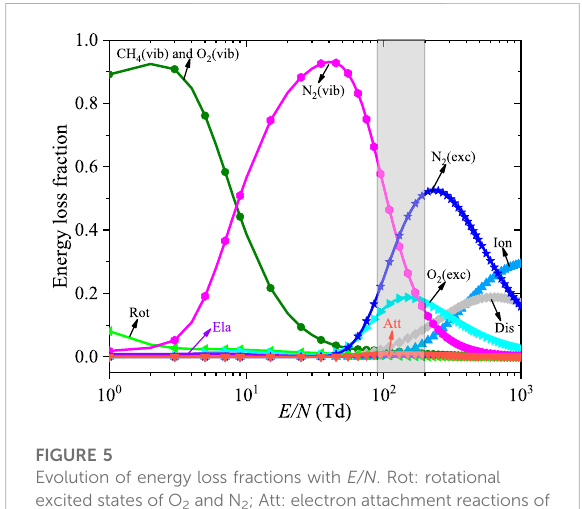
FIGURE 5 Evolution of energy loss fractions with E/N . Rot: rotational excited states of O 2 and N 2 ; Att: electron attachment reactions of CH 4 and O 2 ; Ela, Dis, and Ion represent the elastic collision, dissociation, and ionization in CH 4 /air plasma,